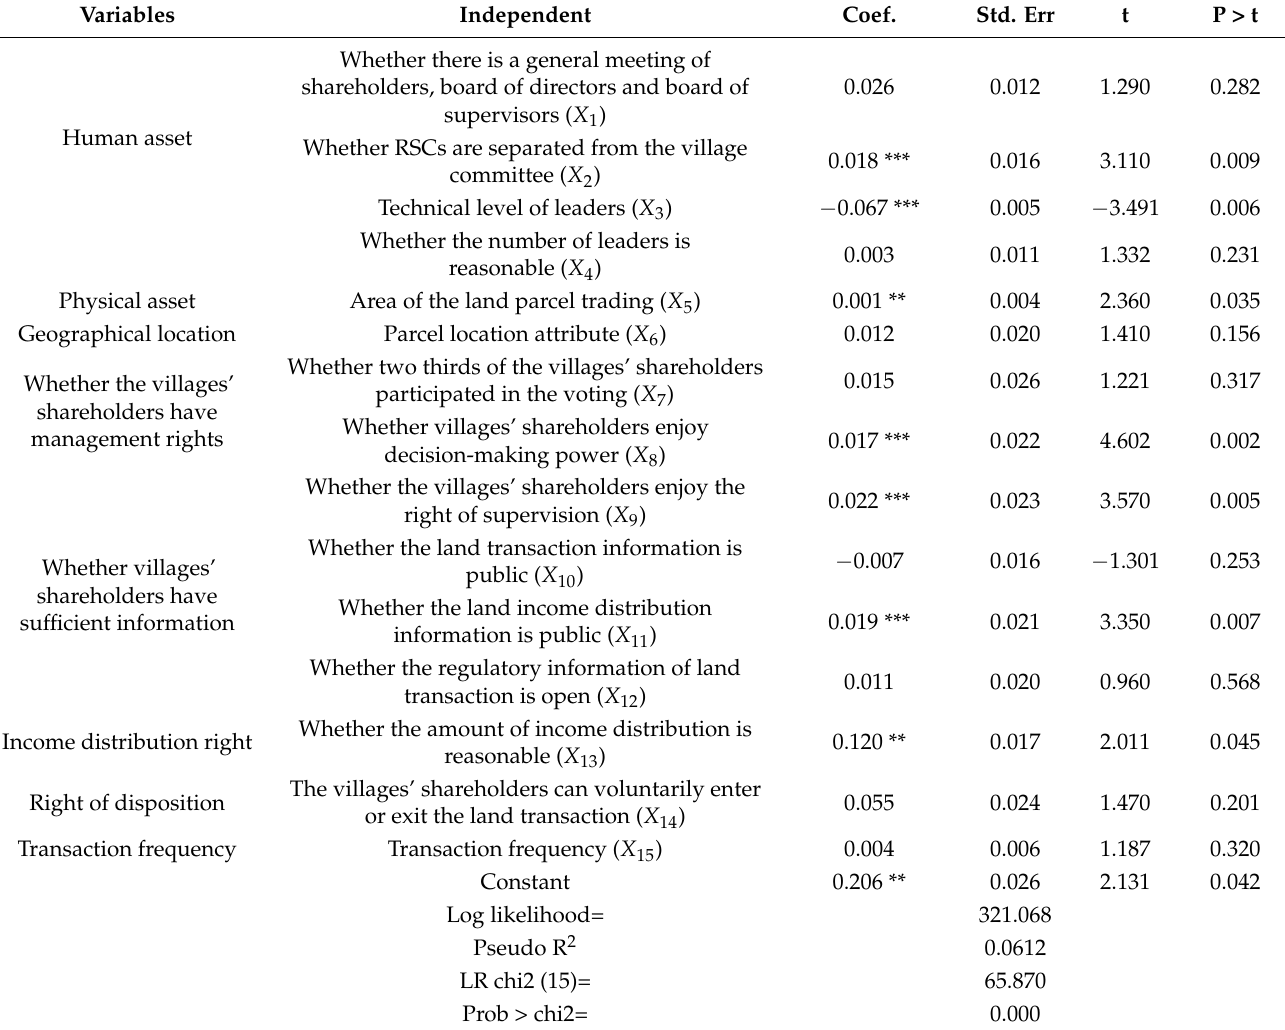
Table 2. The results of the tobit